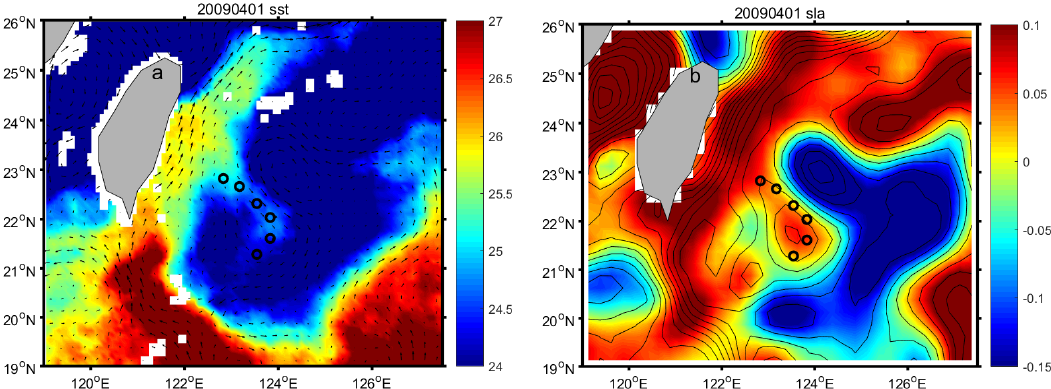
Figure 3. Snapshot of ( a ) SST (color, ◦ C) and geostrophic velocity (vectors); ( b ) SLA (color, in m) and ADT contours on 01 April 2009. Warm filaments are marked by small circles near the center of the frame accompanied by a dipole pair of opposite eddies.